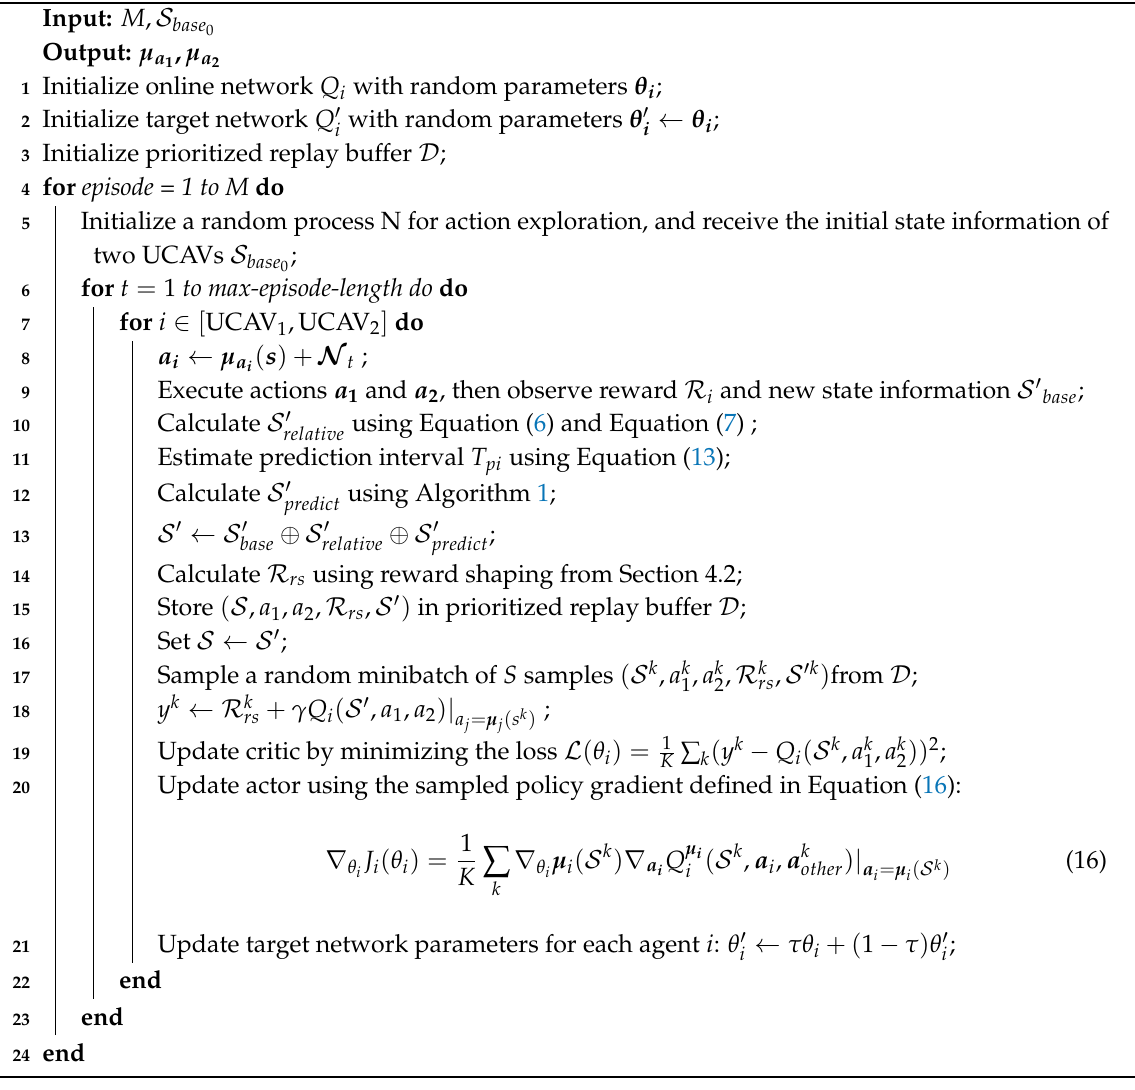
Algorithm 2: Multi-agent deep deterministic policy gradient (MADDPG) Training process for 1-vs.-1 within visual range (WVR) air combat